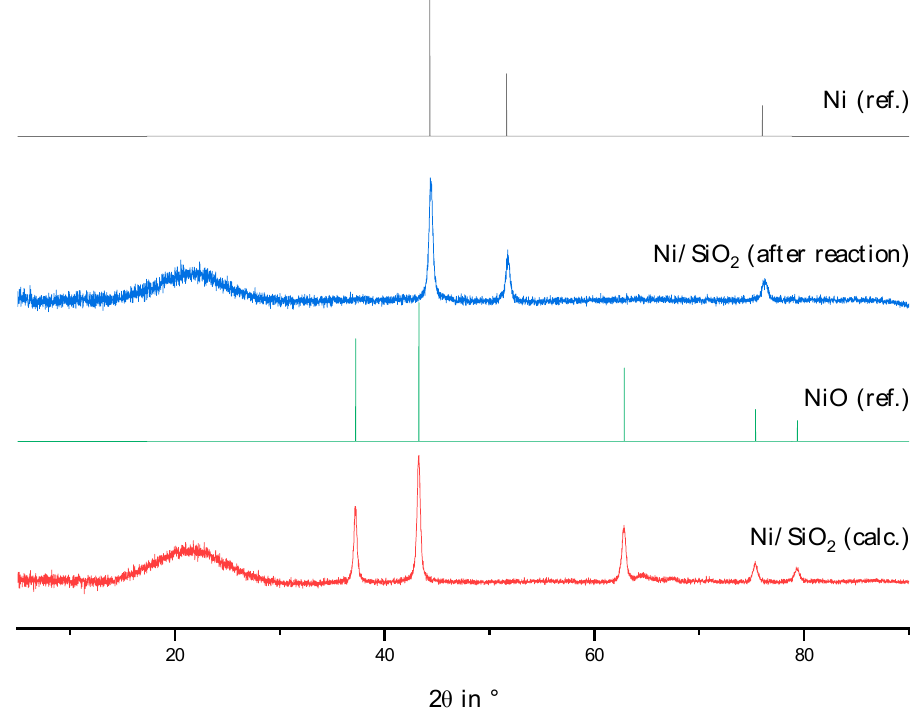
Figure A6. P-XRD of calcined cobalt catalyst before reaction (calc.) and after reaction.